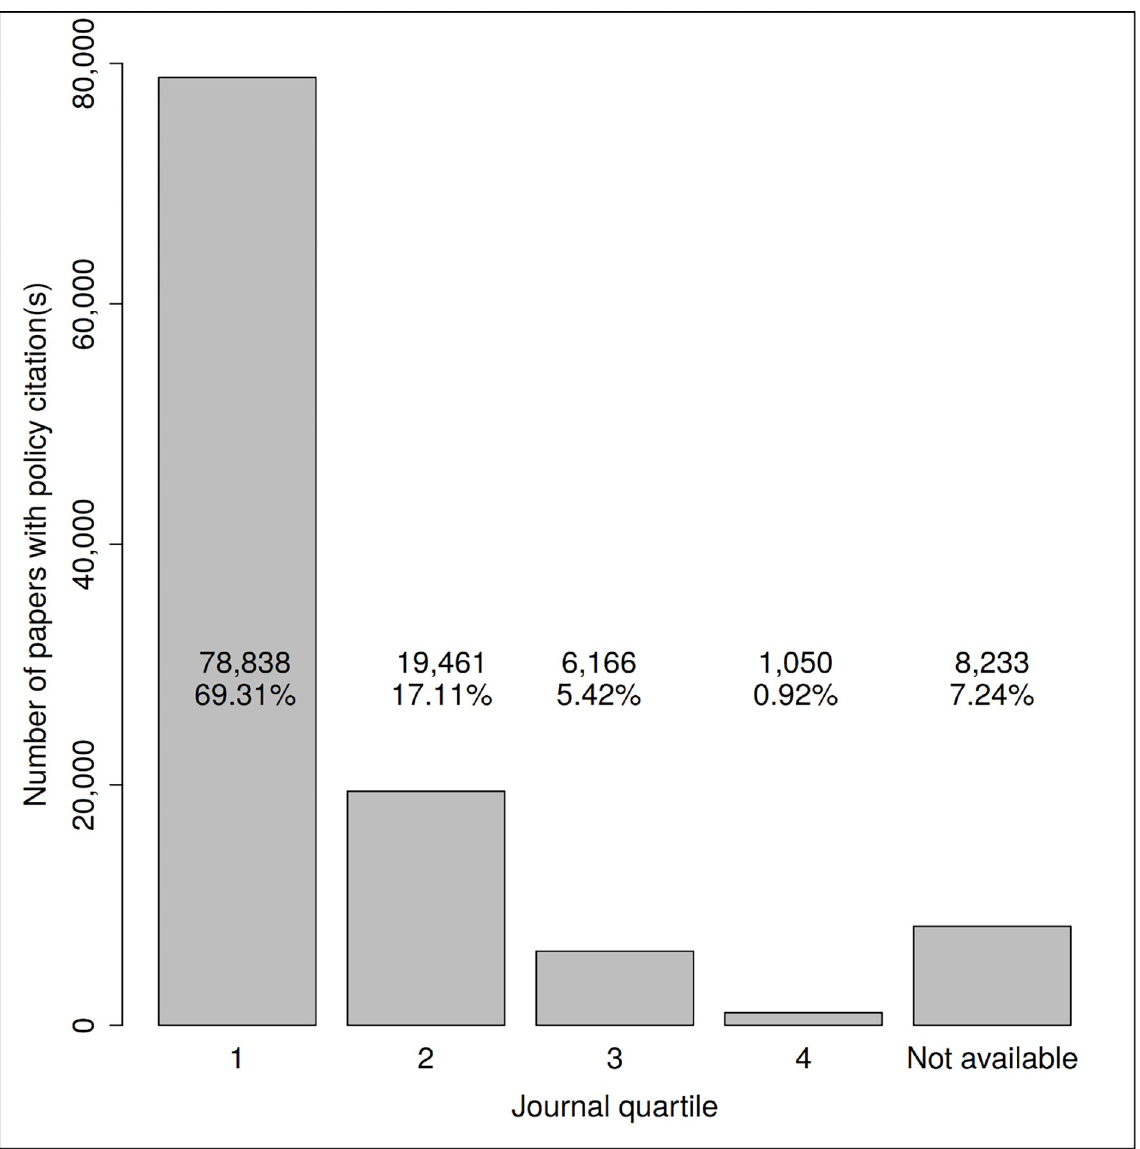
Fig 7. Number of papers with at least one policy citation grouped by CiteScore quartile of the journal. In the first journal quartile, e.g., are those journals that belong to the 25% of the journals with the highest CiteScore in their subject areas. For about 7% of the journals, a CiteScore was not